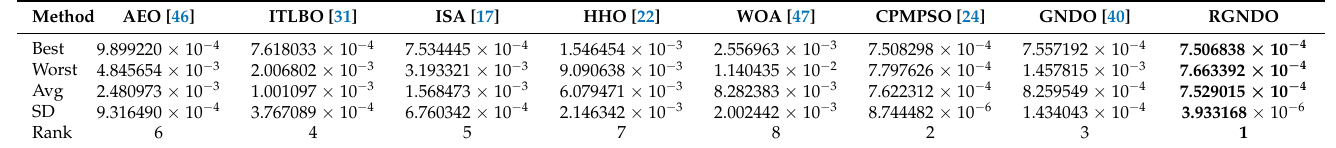
Table 6. Comparison among algorithms on RTC France under the statistical